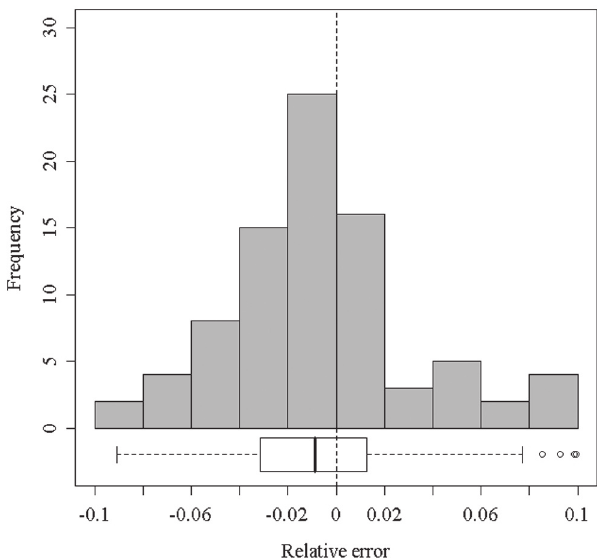
Fig. 3. Histogram and boxplot showing the distribution of the relative errors of length estimates for three plastic silhouettes of 112 mm, 360 mm and 444 mm. The boxplot below indicates a median relative error = -0.9%. The maximum number of A. patachonicus within the field of view was reached 11 – 12 min after deployment.